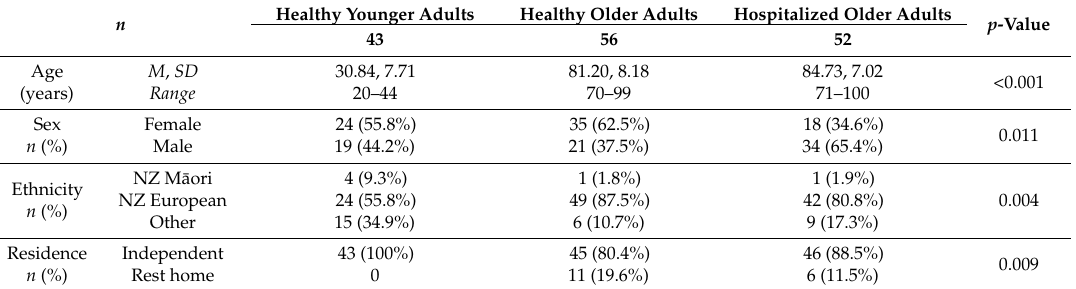
Table 2. Demographics of the participants.